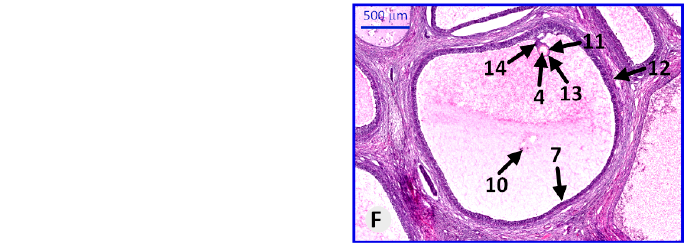
Figure 3. Paraffin section of porcine ovary stained with hematoxylin and eosin (H&E), representing the histological structure of ovary and follicles in particular stages of maturation. ( A , B )—representative ovaries with visible follicles in small magnification; ( C )—primordial follicles, ( D )—